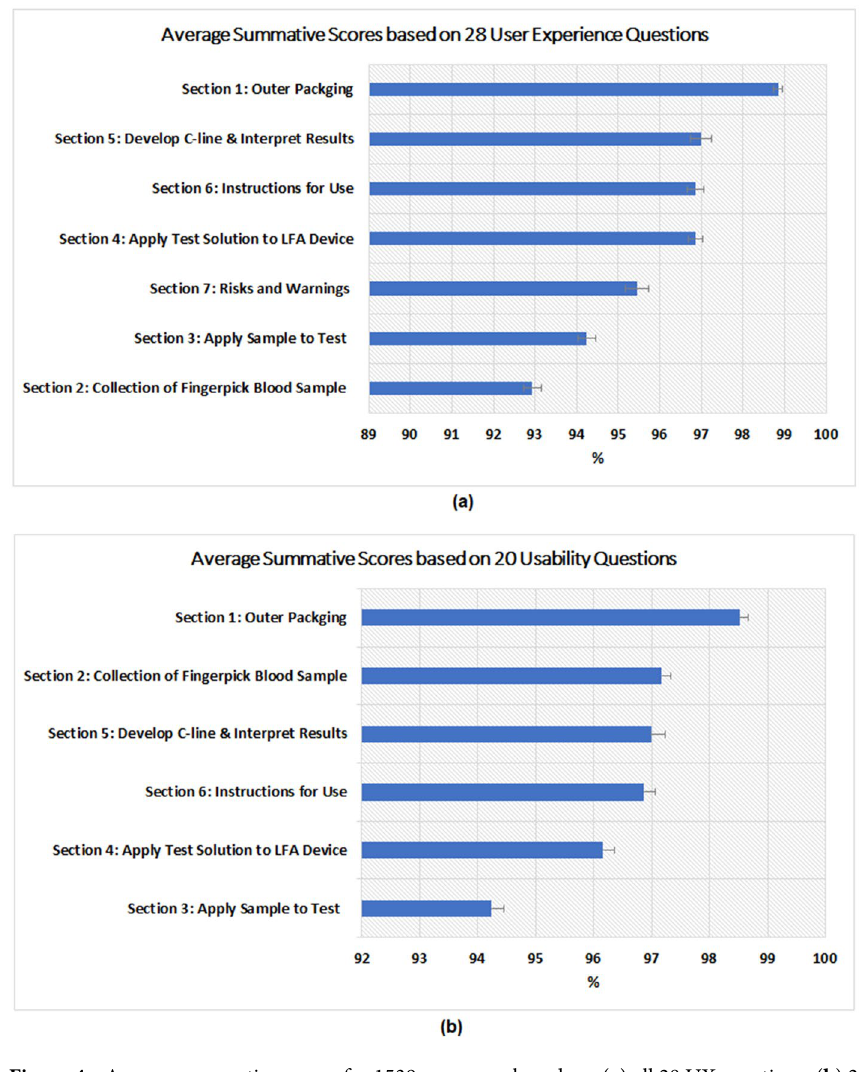
Figure 4. Average summative scores for 1539 responses based on: ( a ) all 28 UX questions; ( b ) 20 questions related to usability construct only. The error bars represent the standard errors.